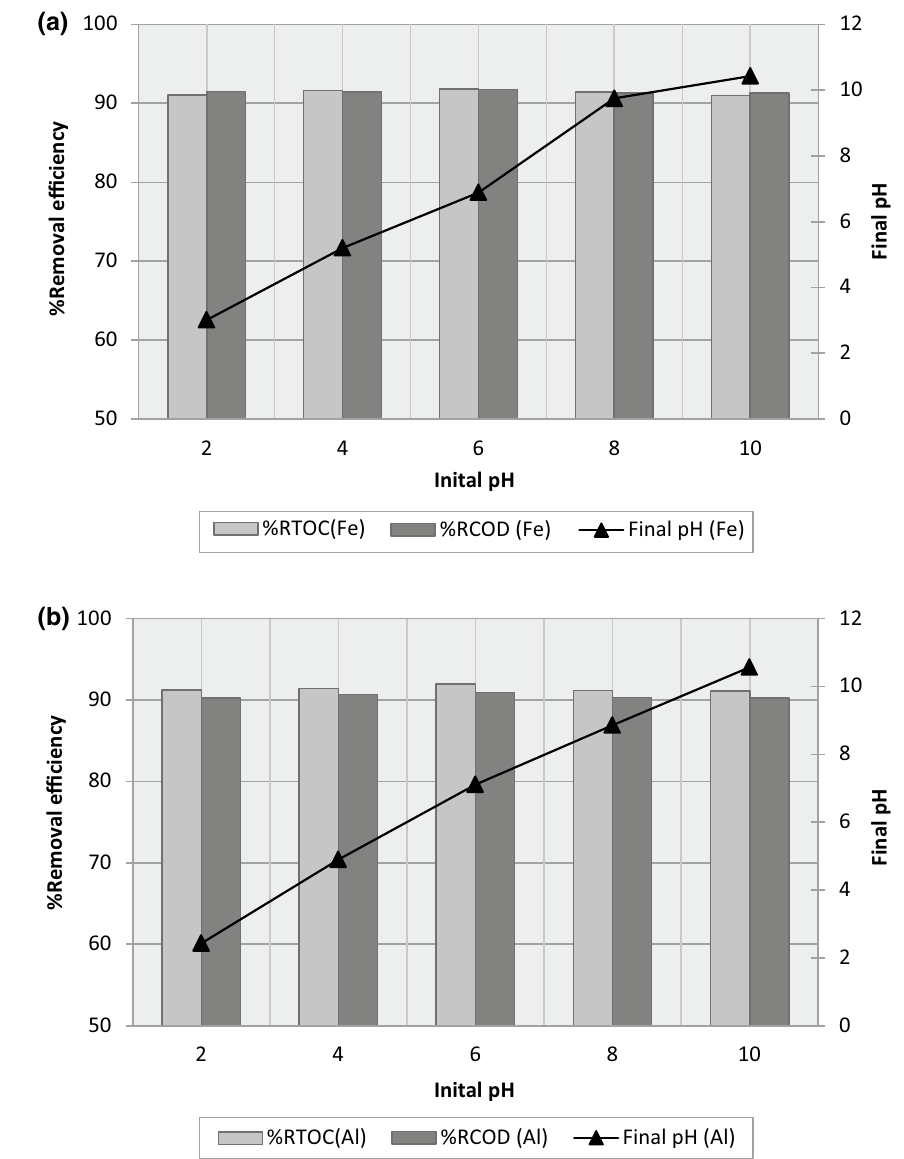
Fig. 3 The effect of pH on the COD and TOC removal efficiency by Fe ( a ) and Al ( b ) electrode ( i = 0.3226 mA/ cm 2 ; C o,COD = 399,800 mg/L; C t = 1 min; o,TOC = 98,120 mg/L; NaCl = 1 g/L; T = 298 K; agita- tion speed = 120